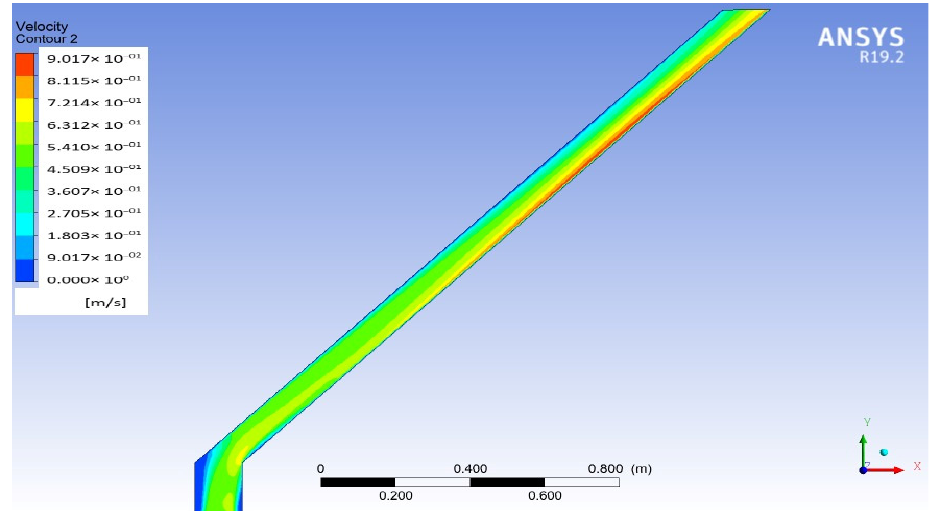
Figure 8. In-plane velocity profile inside the solar chimney.